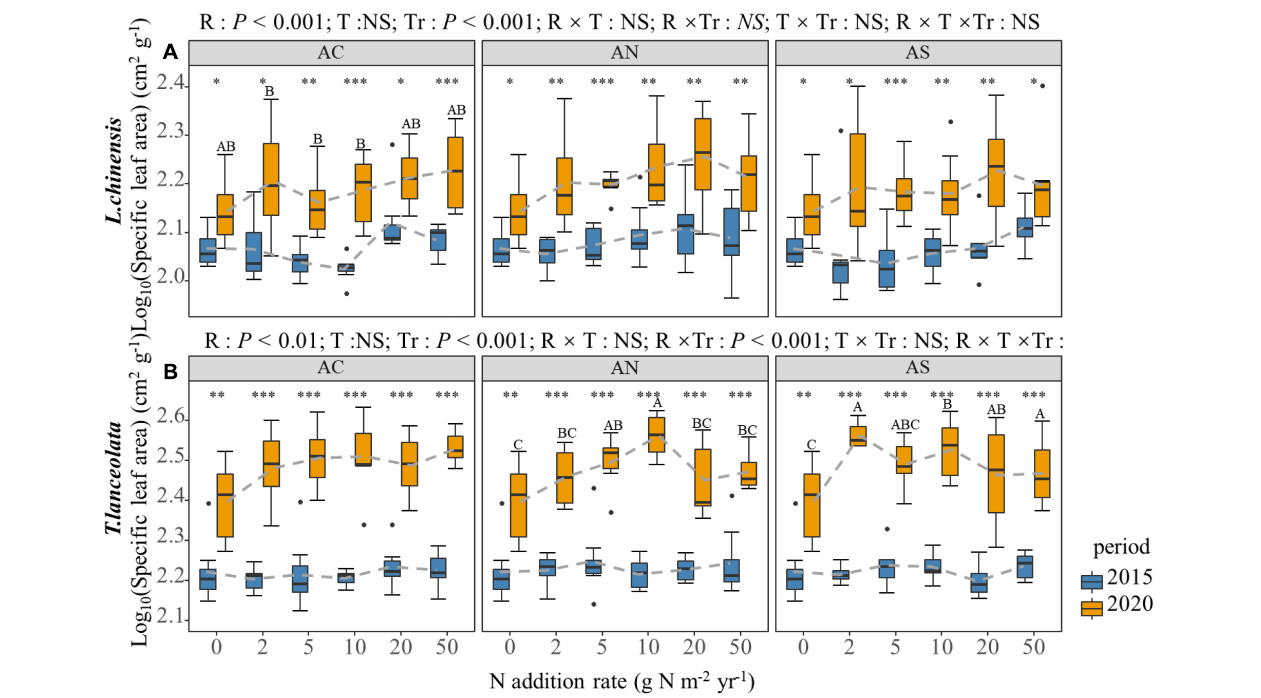
FIGURE 7 | Effects of short- and long-term N deposition on SLA of two species: (A) Leymus chinensis ; (B) Thermopsis lanceolata . The three-way ANOVA was used to test the effects of Pr, T and R on SLA. In order to make the data more stable, the value of the SLA is the logarithm of the original data. The effects of the nitrogen compound type alone and with nitrogen addition rate and year on SLA are not significant (NS, P > 0.05), thus one-way ANOVA (Tukey’s HSD) and t -tests are used to test the effects of nitrogen addition rate and year on SLA. Different lower-case and upper-case letters indicate significant differences ( P < 0.05) in LN among nitrogen addition rate in the 2015 and 2020 plots, respectively. The asterisk above the picture indicates the significant difference between the two years under each nitrogen addition rate. Note: ∗ P < 0.05; ∗∗ P < 0.01; ∗∗∗ P < 0.001. CK: non-fertilizer control = 0, N1 = 2, N2 = 5, N3 = 10, N4 = 20, and N5 = 50 kg N ha − 1 yr − 1 ; AC